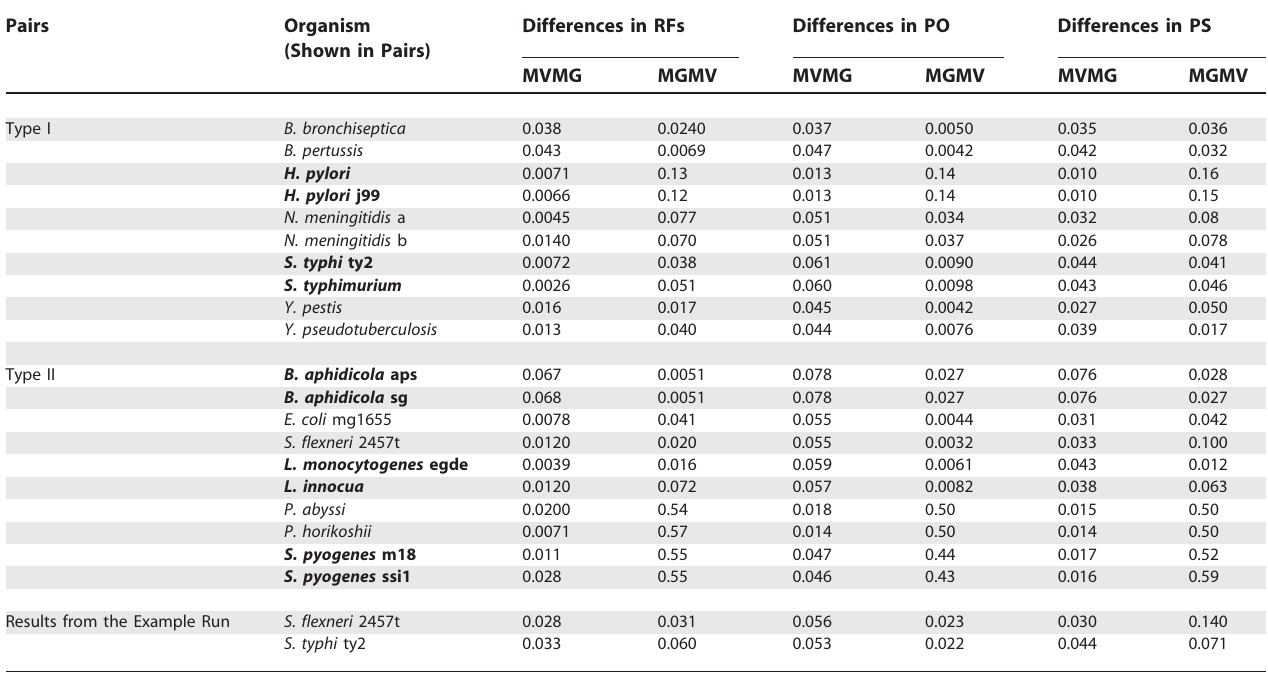
Table 3. Comparing Coverage between MAGIC’s Results and Mauve’s Results When Run with Default Parameters Pairs Organism Differences in RFs Differences in (Shown in Pairs)